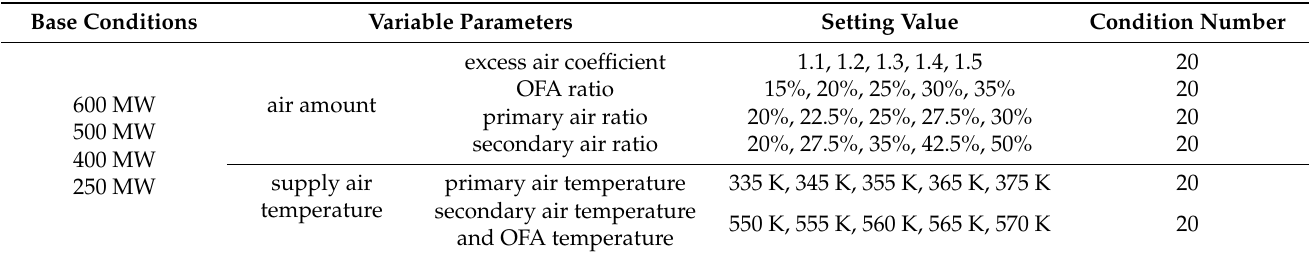
Table 4. Conditions of variable air distribution rate and variable air distribution